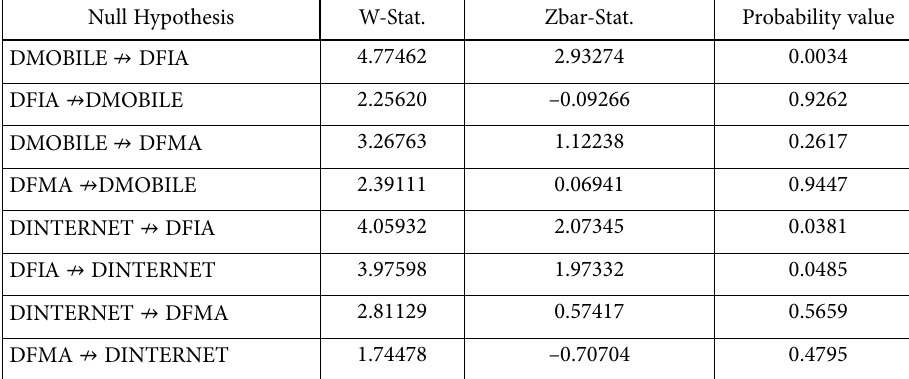
Table 8. Dumitrescu and Hurlin (2012) causality test results Null Hypothesis